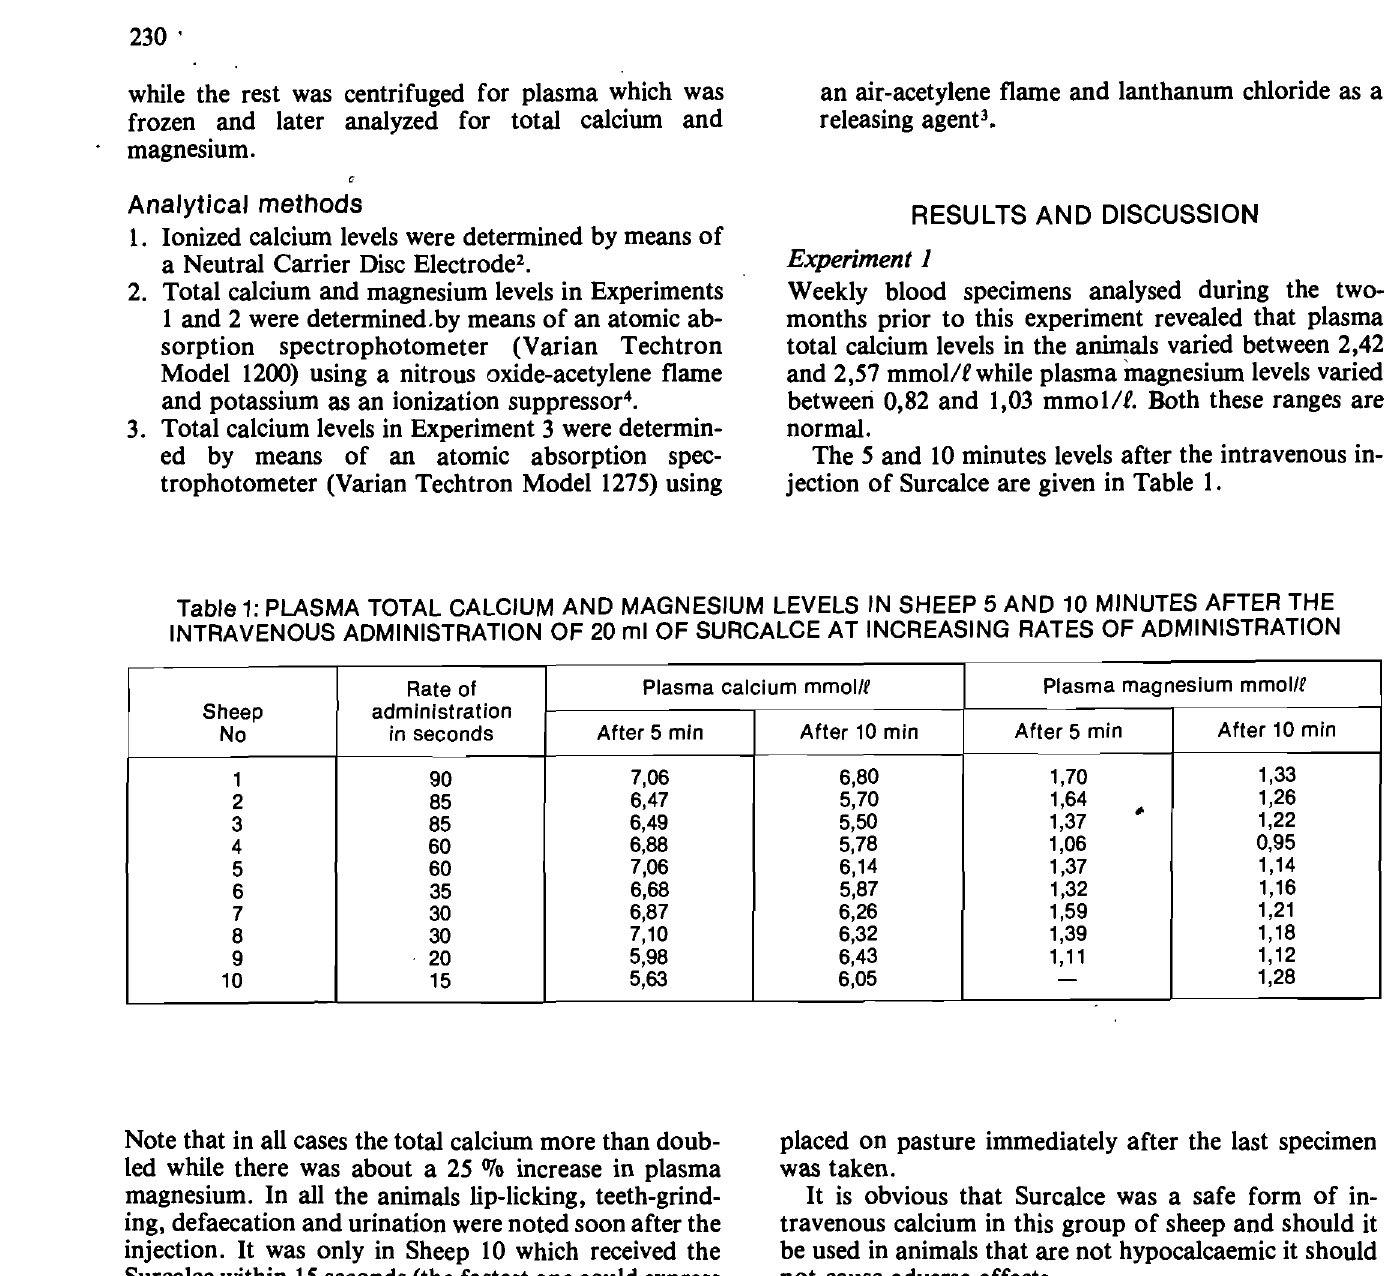
Table 2: THE MEAN (±SE) PLASMA TOTAL CALCIUM, IONIZED CALCIUM AND TOTAL PLASMA MAGNESIUM LEVELS IN 4 SHEEP BEFORE AND AFTER AN INTRAVENOUS INJECTION OF 20 ml OF